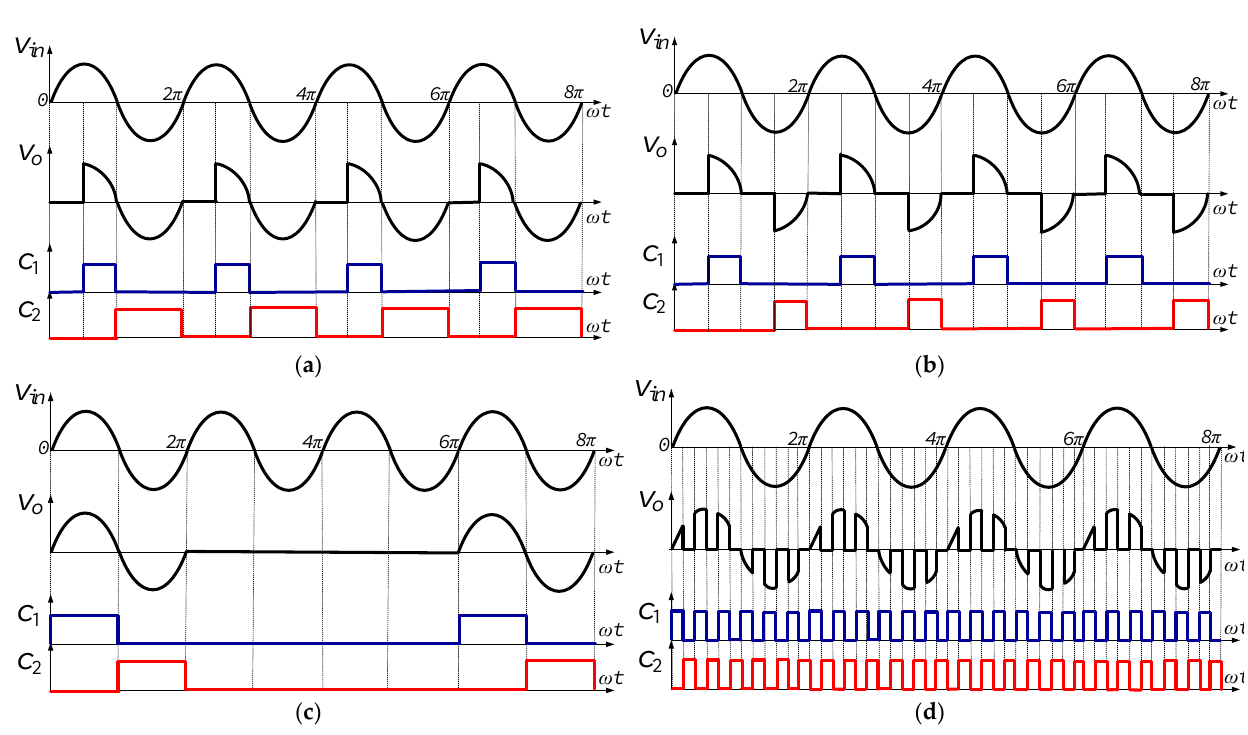
Figure 8. Output rms voltage control: ( a ) half-wave control; ( b ) full-wave control; ( c ) on-off cycle control; ( d ) PWM chop- ping.